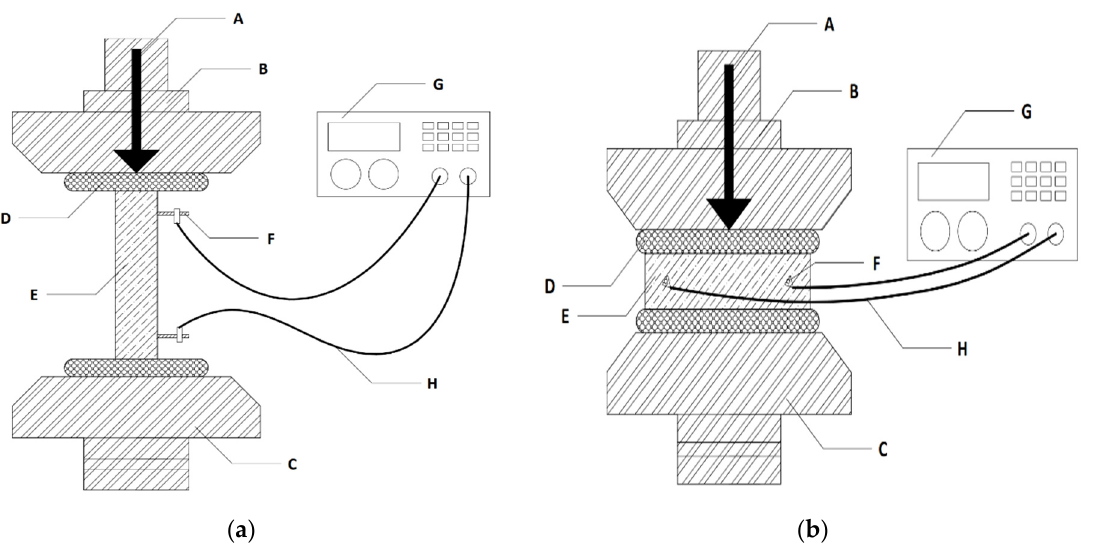
Figure 4. ( a ) Horizontal loading scheme; ( b ) Vertical loading scheme: A—Loading direction, B—Upper jaw of the hydraulic press, C—Lower jaw of the hydraulic press, D—HDPE protecting element, E—Test specimen, F—Electrode, H—Cable, and G—LCR meter.